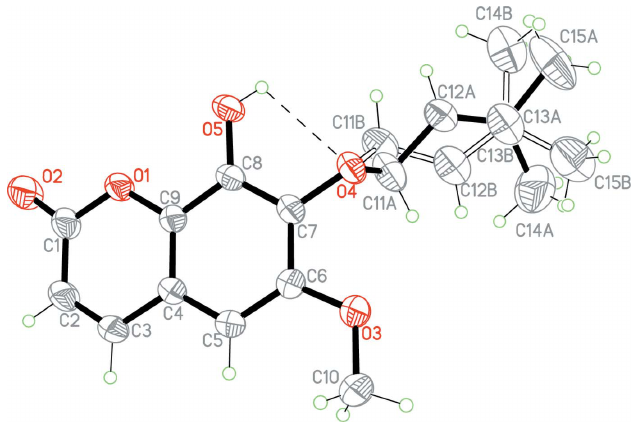
Figure 1 The molecular structure of the title compound with atom labelling. Displacement ellipsoids are drawn at the 50% probability